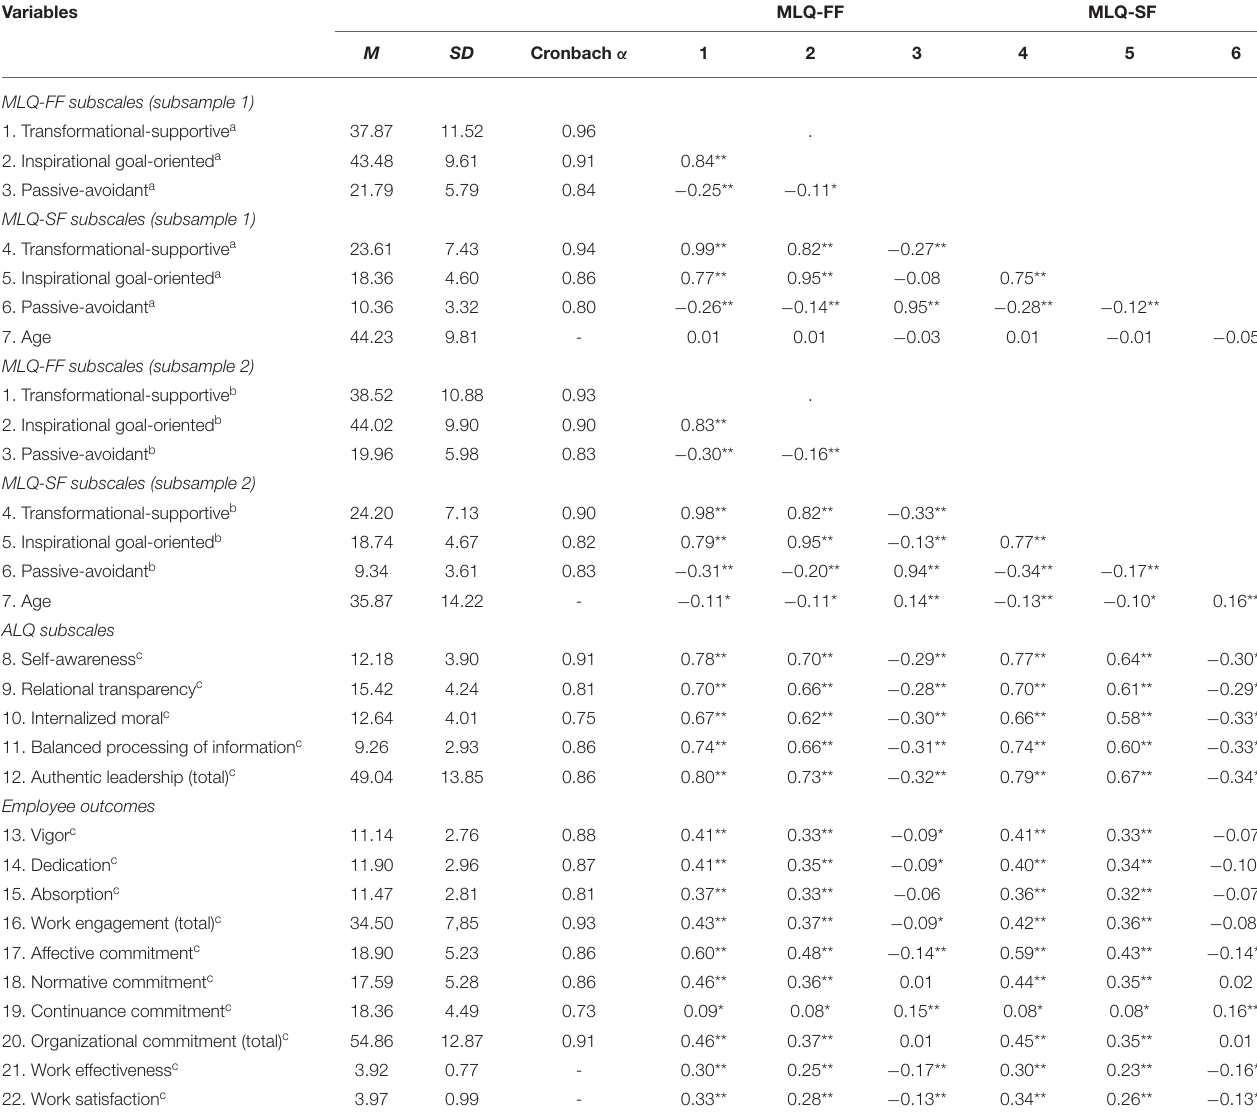
TABLE 4 | Means, standard deviations, Cronbach α , and correlations for all analyzed variables. Variables MLQ-FF MLQ-SF